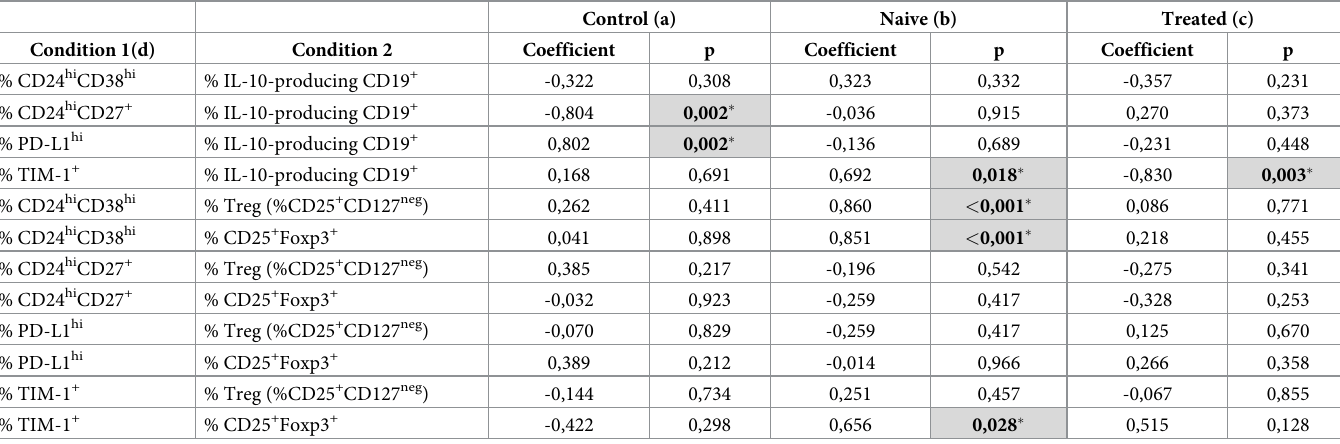
(a) Control: healthy individuals; (b) Na ï ve: treatment-na ï ve HIV + patients. (c) Treated: treated HIV + patients. (d) Gated on CD19+ cells. Frequency of Treg (CD25 + CD127 neg , frequency calculated relative to CD4+ T cells) or CD25 + Foxp3 + (frequency calculated relative to CD4 + T cells) were determined on whole blood or on isolated PBMC,